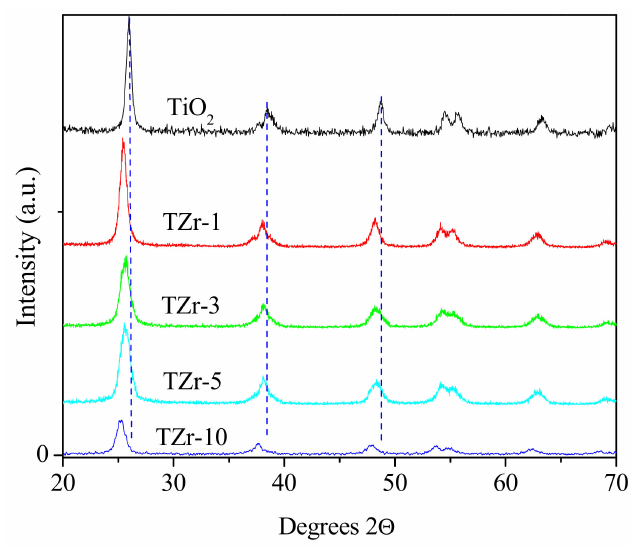
Figure 3. X-ray di ff raction patterns of the Ti–Zr catalysts.